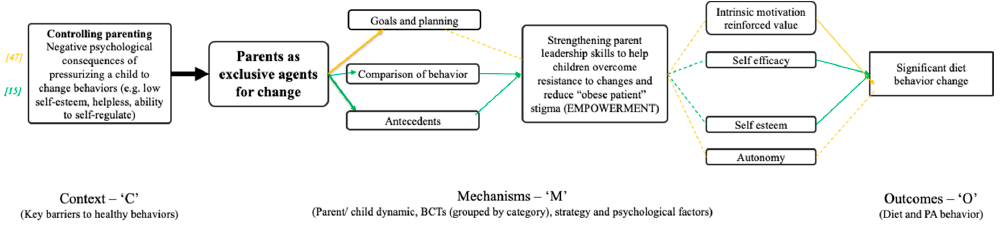
Figure 4. C-M-O pattern based on interventions with parents as exclusive agents for change. Solid arrows indicate configuration between context, mechanisms and outcomes evidenced by the included studies, and dashed arrows depict those configurations that were hypothesized but not evidenced.